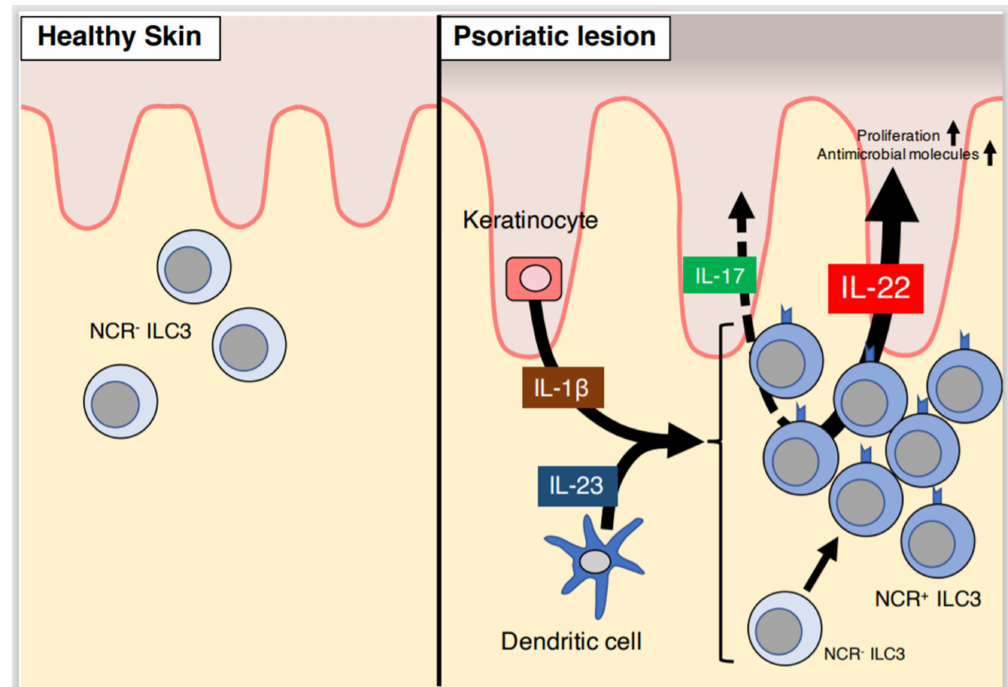
Figure 1. Role of group 3 innate lymphoid cells (ILC3s) in psoriatic lesions. In healthy skin, a few natural cytotoxicity receptor-negative (NCR – ) ILC3s are present in the dermis. Contrastingly, NCR + ILC3s are increased in psoriatic lesions. NCR – ILC3s may convert to NCR + ILC3s in response to cytokines secreted by keratinocytes and dendritic cells. NCR + ILC3s produce IL-22, rather than IL-17, in response to IL-23 secreted by dendritic cells and IL-1 β secreted by keratinocytes. IL-22, and potentially IL-17, secreted by NCR + ILC3s contribute to the pathogenesis of psoriasis. Table 1. The Profiles of Innate Immune Cells in the Healthy Condition and Psoriasis. Cell